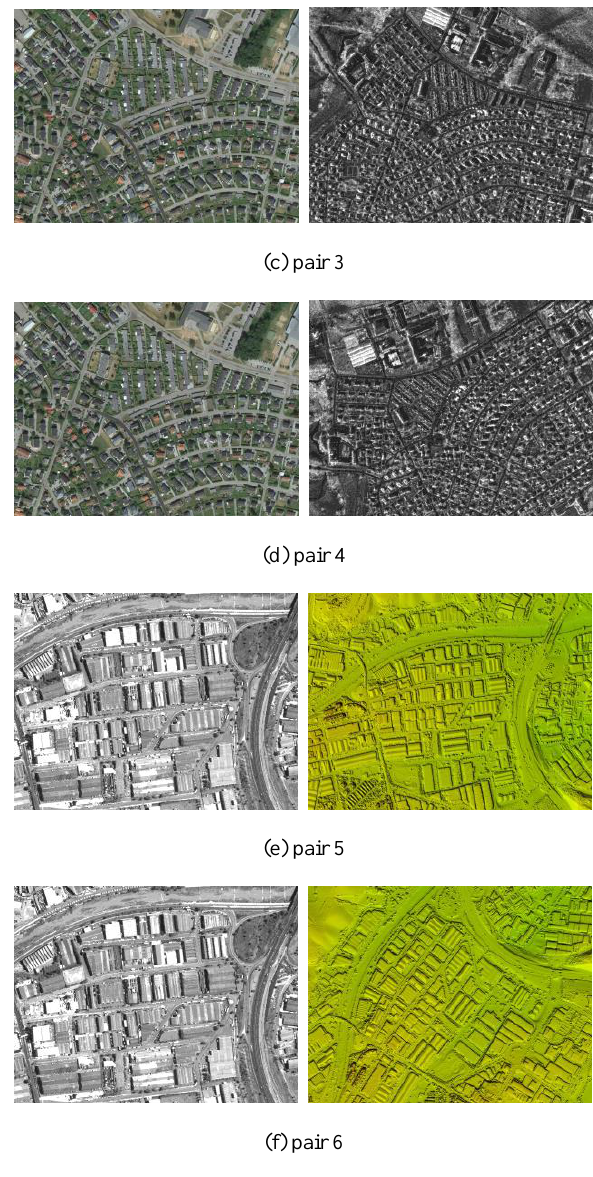
Figure 5. Experimental datasets. (a) and (b) are visible-to- infrared image pairs. (c) and (d) are optical-to-SAR image pairs. (e) and (f) are optical-to-LiDAR image pairs. There